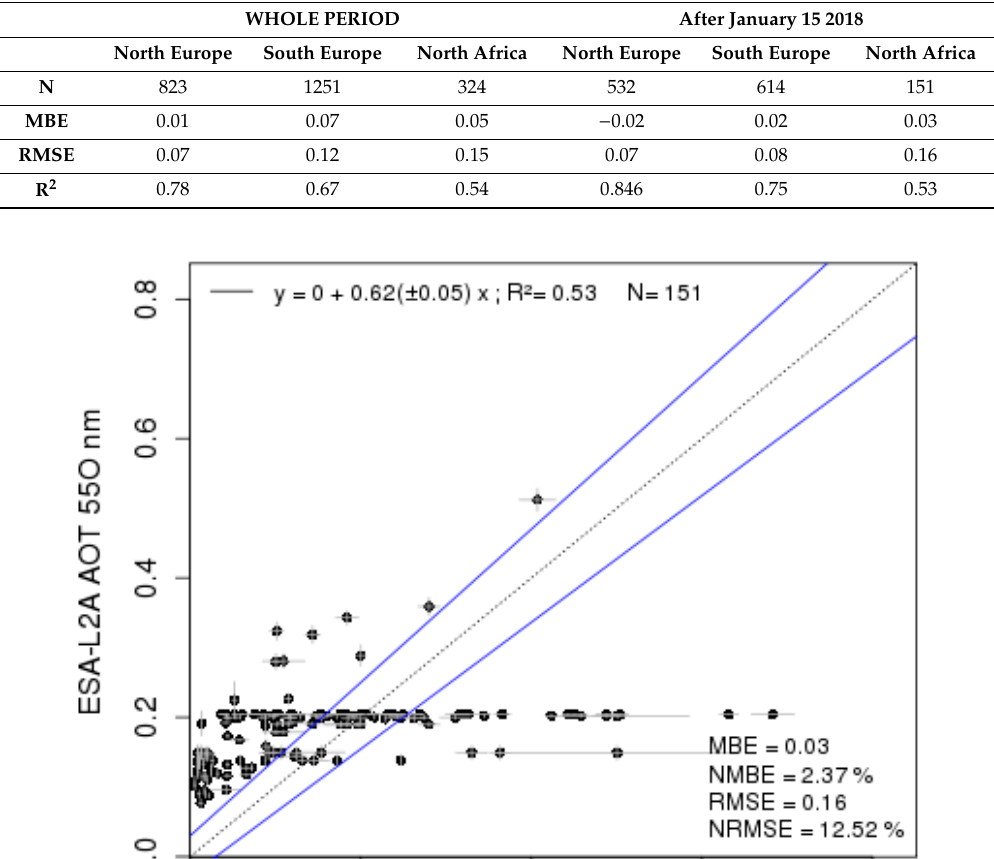
Table 5. MBE, RMSE and R 2 AOT values for different regions (North Europe, South Europe, and North Africa/Middle East) corresponding to the whole period and to the period after 15 January, 2018.